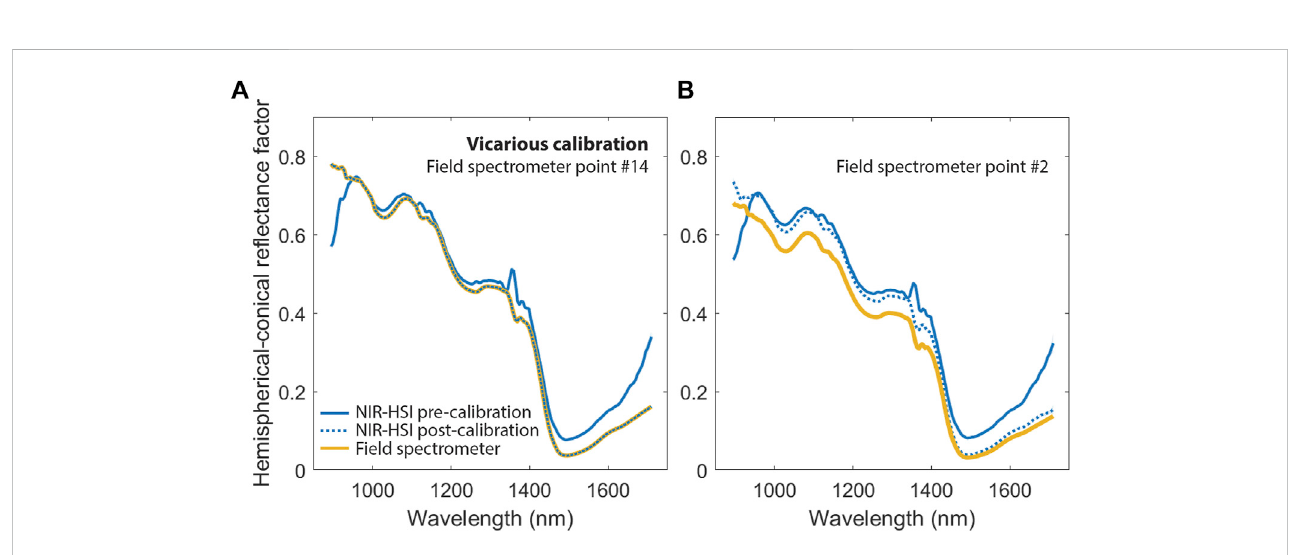
FIGURE 5 (A) NIR-HSI pre- and post-vicarious calibration using the fi eld spectrometer point measurement #14. (B) Field spectrometer point #2 and the pre- and post-vicariously calibrated NIR-HSI spectra at the same